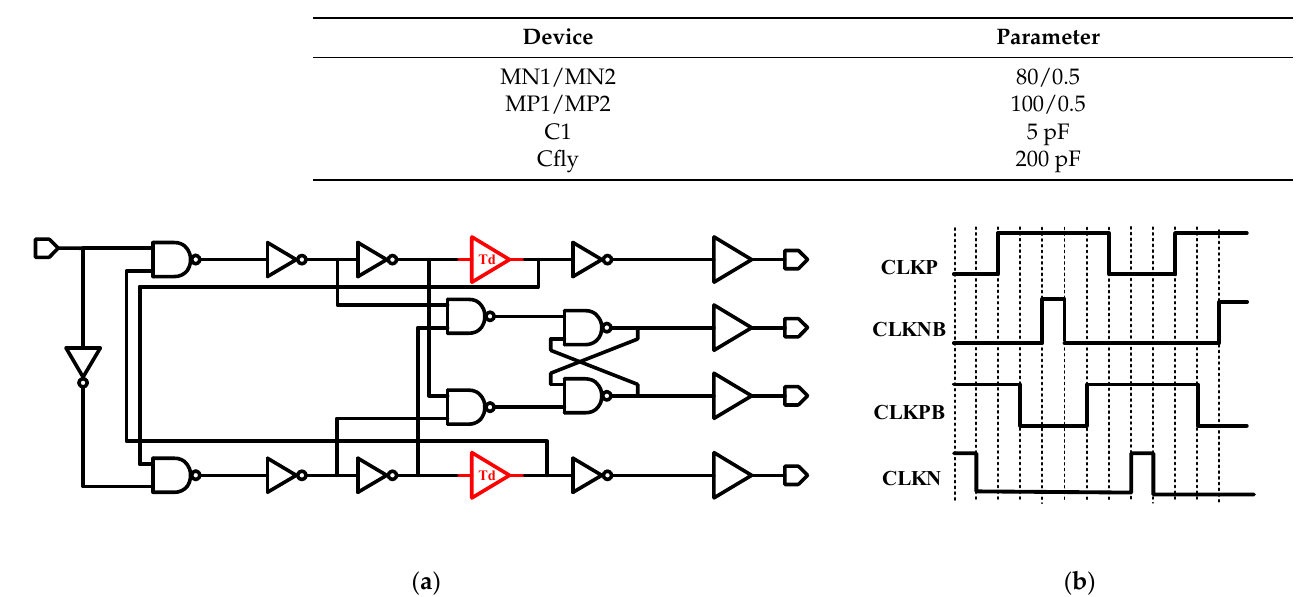
Table 1. The component parameters of the four-phase charge pump.